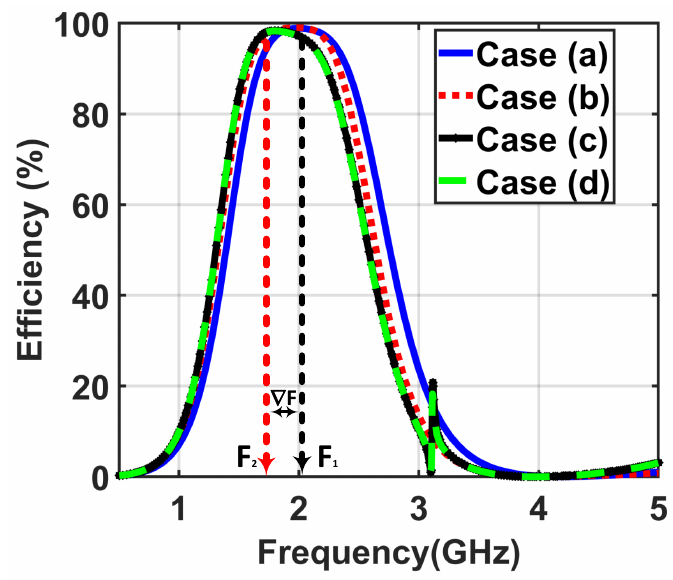
Figure 9. Simulation results of four cases of the proposed supercell: ( a ) case a ( b ) case b ( c ) case c, and ( d ) case d as described within the